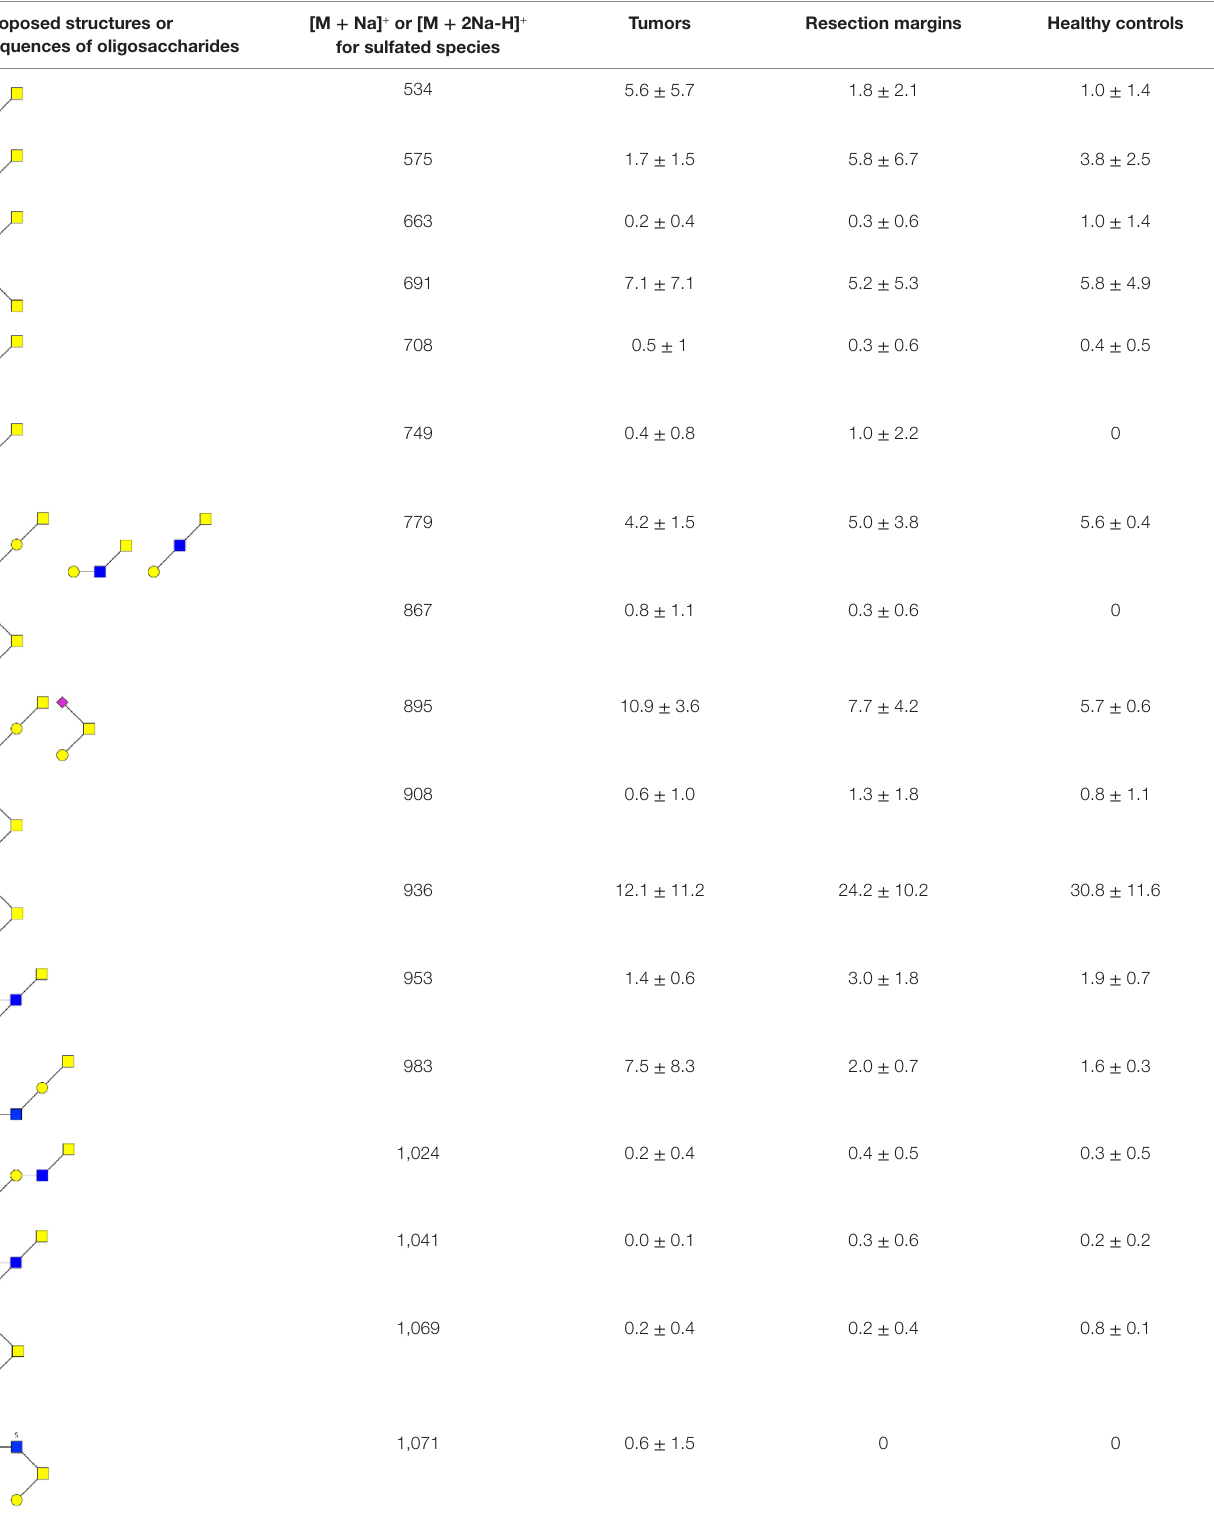
TaBle 2 | Proposed neutral and acidic oligosaccharide structures or sequences identified in human mucins from tumors and resection margins of patients with colorectal cancers and from colonic mucosa of healthy individuals . Proposed structures or sequences of